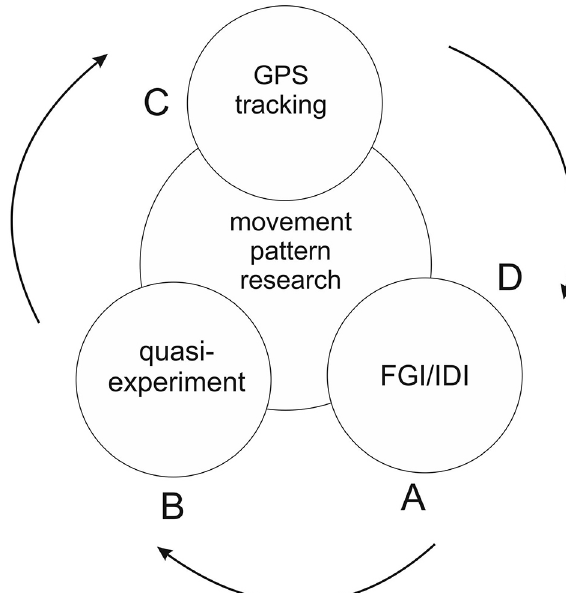
Fig. 1. Methodological triangulation in movement